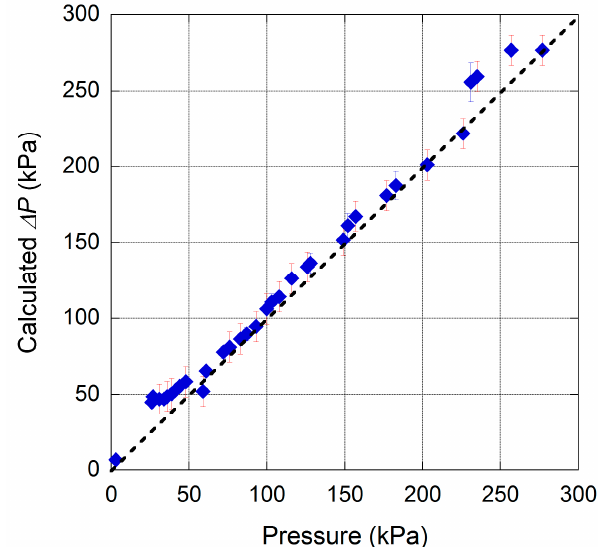
Figure 10. Sensor repeatability has been evaluated under several 0–300 kPa cycles. Best fit of experimental data reported in Figure 9, used to calculate the sensor transfer characteristics, allowed ff erence ∆ P estimation of the inlet pressure difference Δ P . estimation of the inlet pressure di